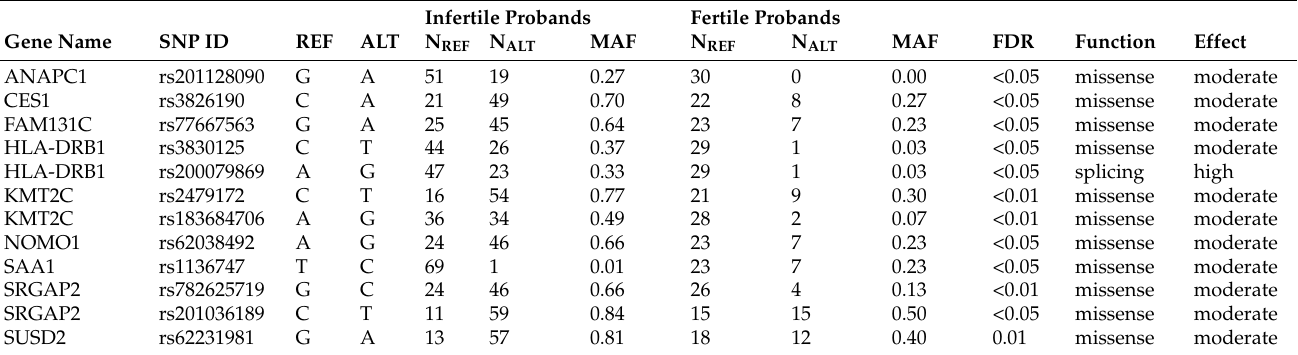
Table 2. Single-nucleotide polymorphisms with different allele frequencies in infertile and fertile men. Infertile Probands Fertile Probands Gene